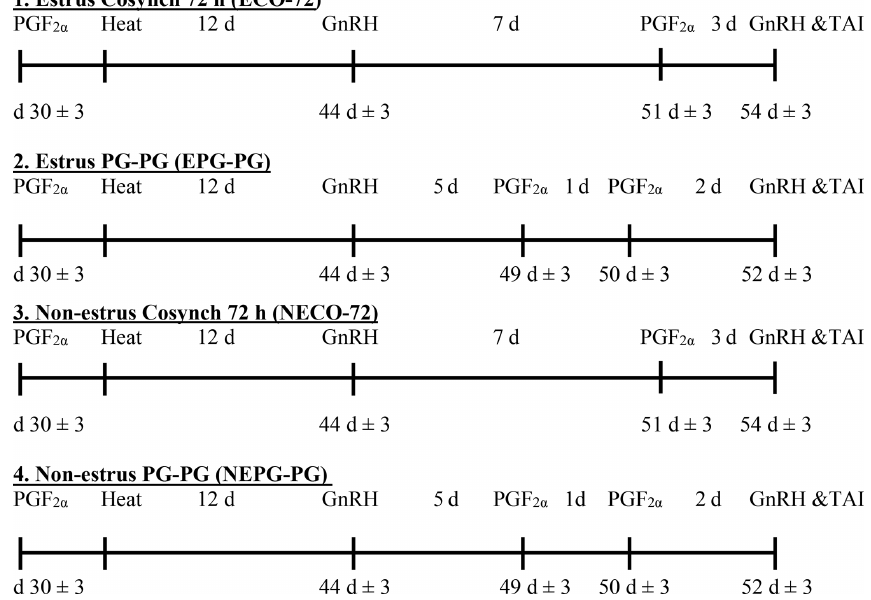
Figure 1. Schematic diagram of the different hormonal treatments of the lactating cows in the study.